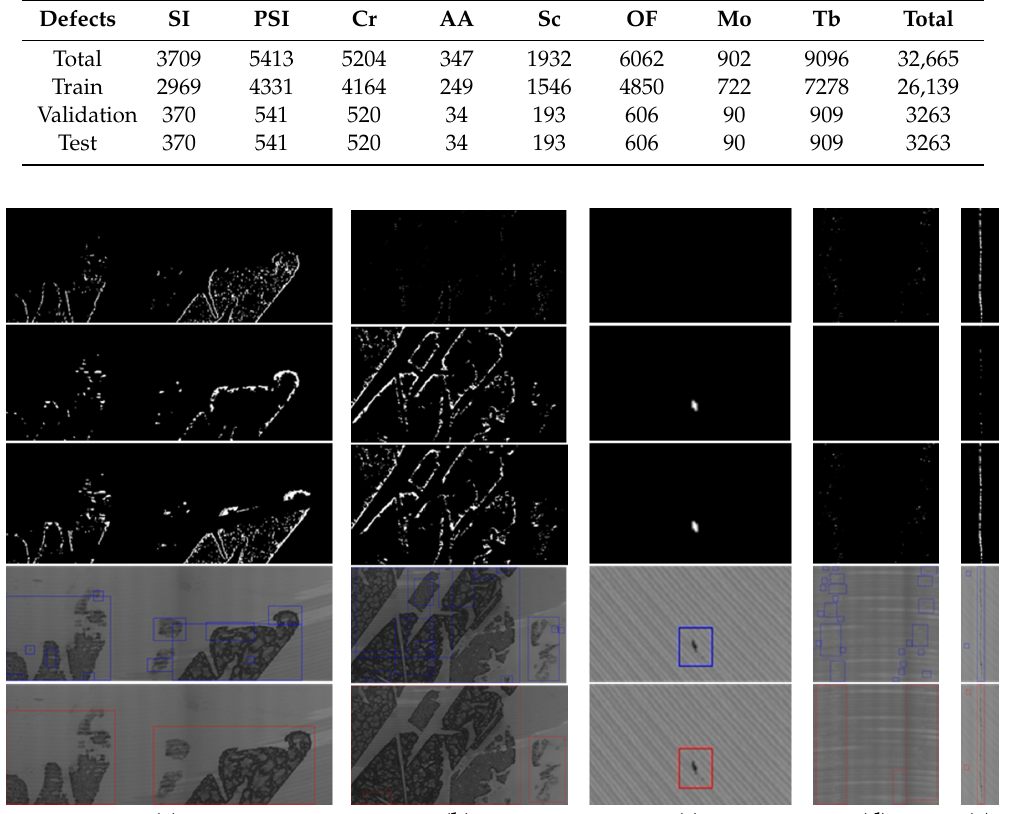
Table 2. Specific of each type of defect used in the classification experiment.